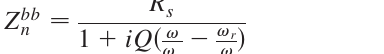
and the SIS, we do observe the formation of large, persis- tent phase space holes similar to Ref. [2] and not the multistream instability.